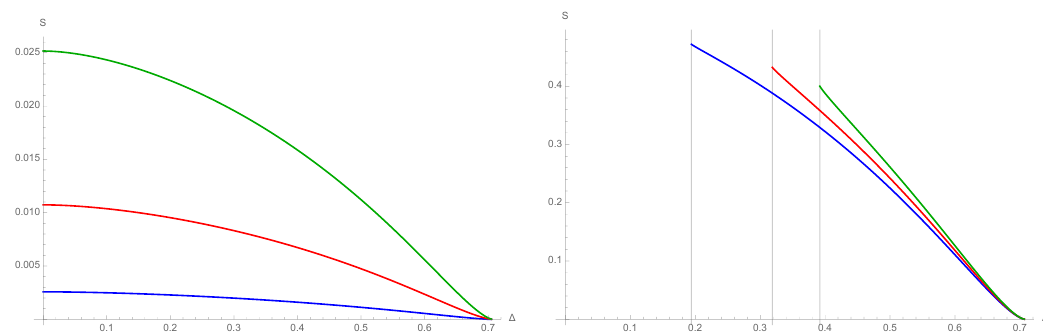
Figure 4 . Total action as a function of the deformation parameter ∆ for values of J 1 < 1 (left √ plot) and for values J 1 (right plot). When J 1 , ∆ takes all the values between 0 and 1 / 2 , 1 > 1 < while for J 1 ∆ is restricted to the values that are above the red line in figure 6. The gridlines 1 > emphasize those values, that are the lower limits for ∆ given a value for J . The correspondence 1 between colors and values of J for the left plot is: Blue ⇒ J = 0 . 1 , Red ⇒ J = 0 . 2 & Green 1 1 1 ⇒ J 1 = 0 . 3 . The correspondence between colors and values of J 1 for the right plot is: Blue ⇒ J 1 = 1 . 01 , Red ⇒ J 1 = 1 . 03 & Green ⇒ J 1 = 1 . 05 .